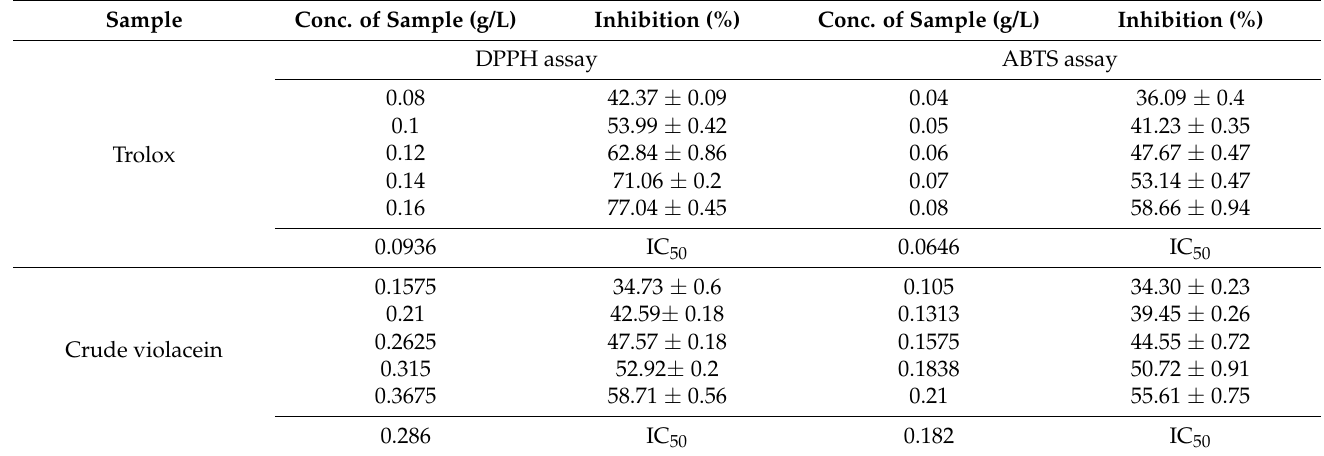
Table 2. Antioxidant effect of violacein against DPPH and ABTS